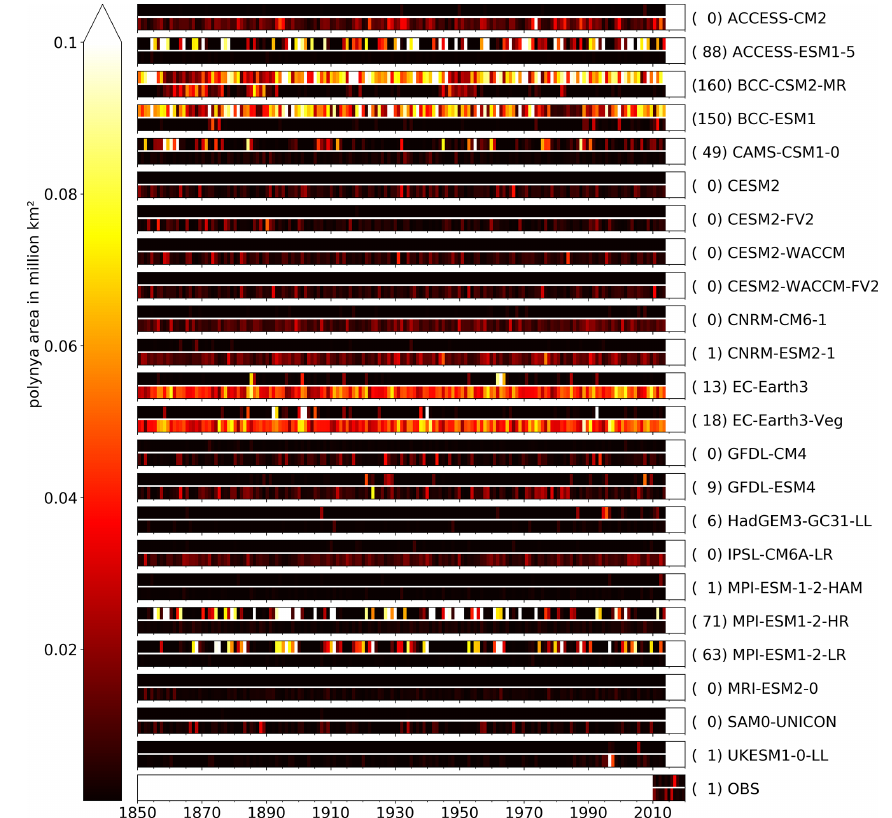
Figure 8. Yearly mean polynya area between May and November in the historical CMIP6 model run for the Weddell Sea region computed from the sea ice thickness. Each bar represents one CMIP6 model and is divided horizontally into the coastal polynya area (upper bar) and OWP area (lower bar). The values next to the model name represent the number of years an OWP with an area of more than 10 . 0 × 10 3 km 2 was